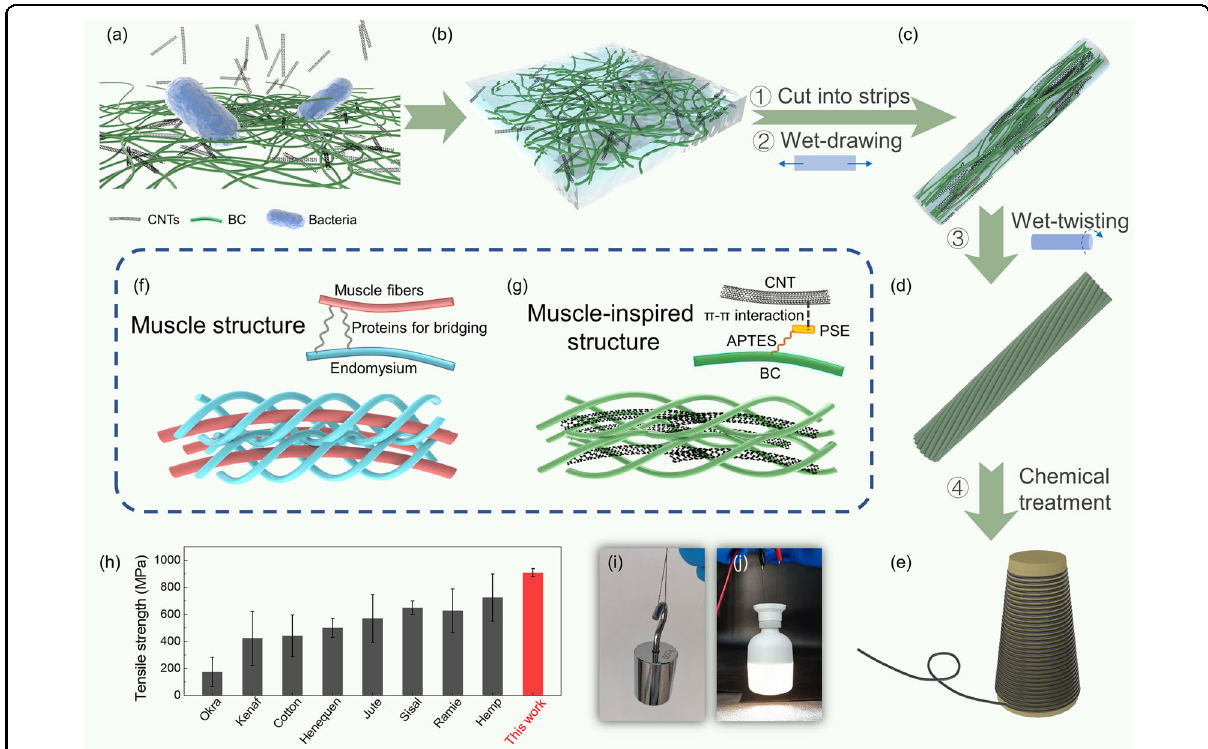
Fig. 1 Fabrication of the muscle-inspired fi bers. a Schematic illustration of the in situ composite preparation through the in situ aerosol-assisted biosynthesis process. Carbon nanotubes (CNTs) are continuously settled and entangled by bacterial cellulose (BC) nano fi bers. b The composite hydrogel with CNTs uniformly distributed in the 3D network of BC. c The obtained hydrogel strips are transformed into oriented fi bers through wet drawing. d After wet twisting, the composite fi bers are further densi fi ed and shaped. e After chemical treatment, muscle-inspired fi bers are obtained. f The exquisite fascicle structure of skeletal muscle with muscle fi bers embedded in the 3D network of the endomysium through proteins for bridging. g The muscle-inspired structure with CNTs embedded in the 3D network of BC through π – π interactions. h The tensile strength of the muscle-inspired fi bers is higher than that of typical natural fi bers. i The muscle-inspired fi bers with a diameter of approximately 0.21 mm can stably be loaded with a weight of 0.5 kg. j The muscle-inspired fi bers are used to hang a light